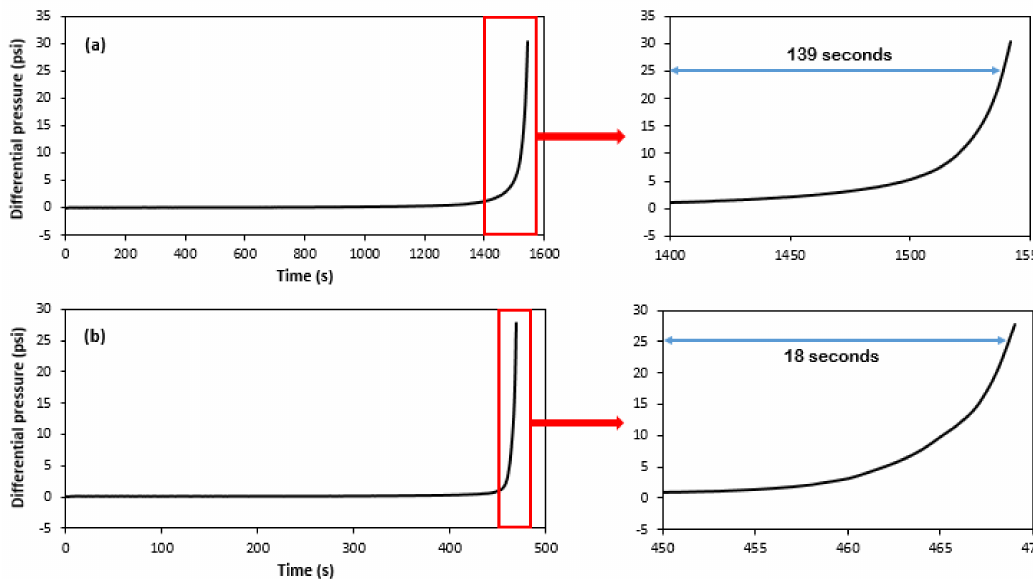
Figure 3. The measured differential pressure over time for ( a ) experiment #1 and ( b ) experiment #11 (Table 1), showing details about the speed evolution of the scale build-up